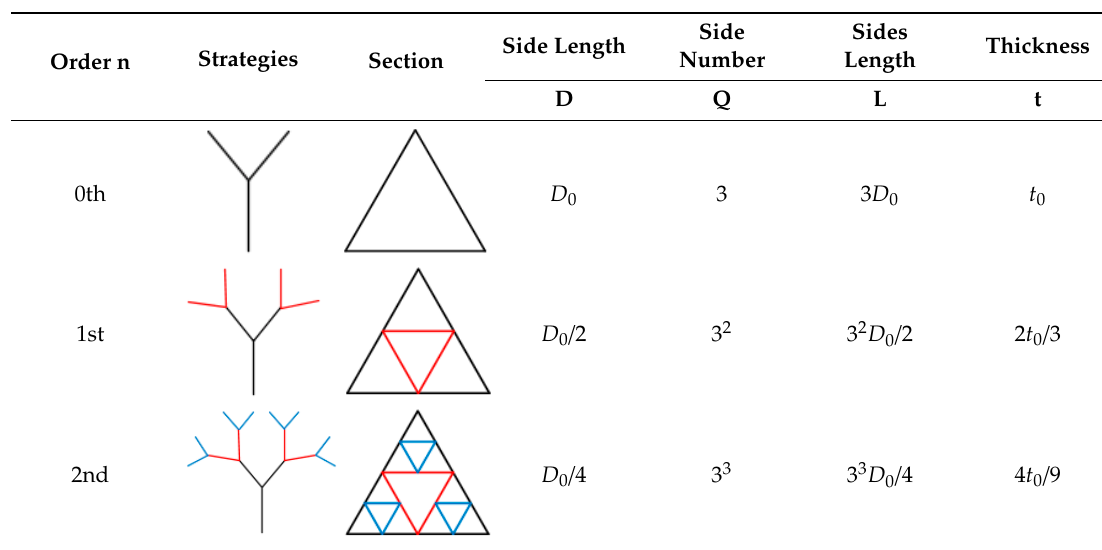
Table 1. Configuration details of fractal